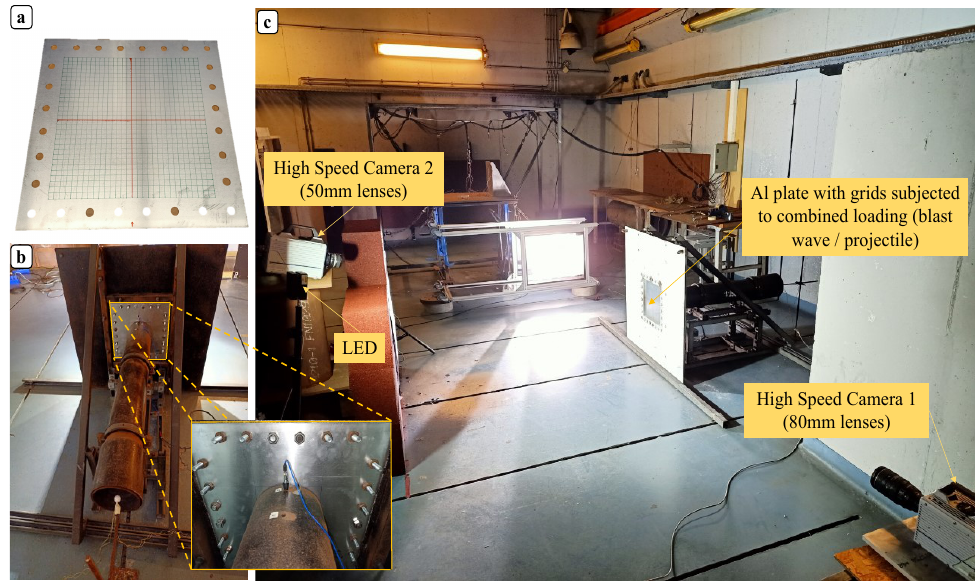
Figure 13. ( a ) Front face view of the Al plate target showing the grid, ( b ) Al plate positioned at the exit of the EDST and fixed to the steel frame, ( c ) image showing the position of HSC2 in the setup. Images from HSC2 show: (i) the plate deformation at different time steps resulting from the explosion of 10 g of C4 at the entrance of the EDST and, (ii) the position of the projectile’s impact point on the plate. Three different stages can be distinguished as shown in Figure